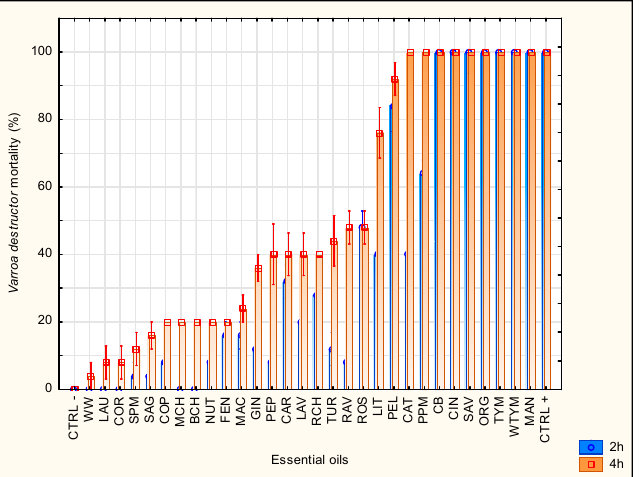
Figure 1. Mortality rates of Varroa destructor in glass vial bioassay after 2 and 4 h of EO exposition. The error bars denote standard deviation. Full name of each abbreviation is shown in Table